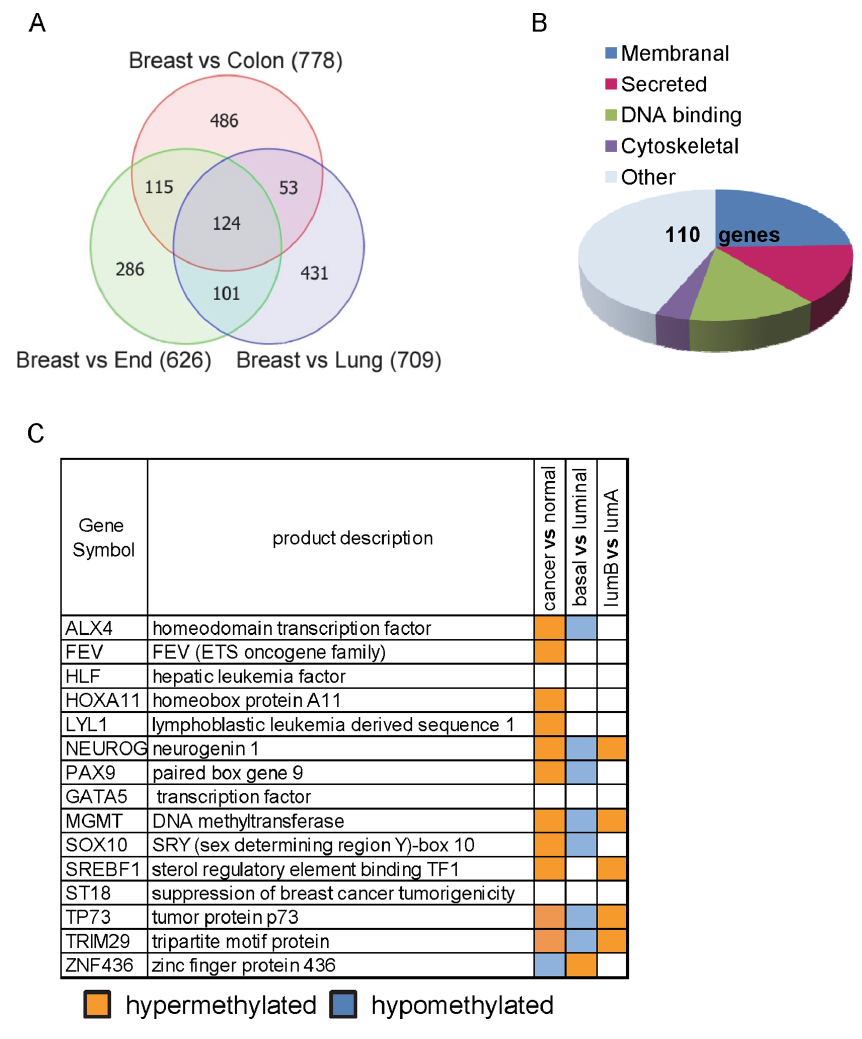
Figure 2. Differentially methylated promoter regions in normal breast epithelium. ( A ) Venn diagram showing differential methylation loci in breast epithelium (organoids, n=6) as compared to colon (n=2), lung (n=2) and endometrial (End) epithelial tissues (n=2). About 700 loci (number indicated in brackets) were differentially methylated in breast epithelium when compared to either of the colon, lung or endometrial epithelium. 124 loci had unique methylation patterns in the breast as compared to the other epithelial tissues. Selection of differentially methylated loci was based on a b -value difference . 0.2 and a P-value , 0.05, after false discovery rate correction, using analysis of variance (ANOVA). ( B ) Functional classification of 110 genes corresponding to the 124 differentially methylated probes (DAVID Bioinformatics Resources 6.7, NIAID). ( C ) Selected sub-group of breast specific methylated genes encoding for DNA binding proteins. TCGA analysis (BRCA methylation Illumina 450 dataset, p , 0.0001 calculated using Bonferroni corrected t-test) revealed methylation alterations in breast cancers (n=497) as compared to normal breast tissues (n=97), in basal (n=31) versus luminal (n=144) breast tumors and in luminal-A (n=99) versus luminal-B (n=45) tumors. The genomic region analyzed for each gene corresponds with the Illumina probes that were found differentially methylated in breast as specified in Table